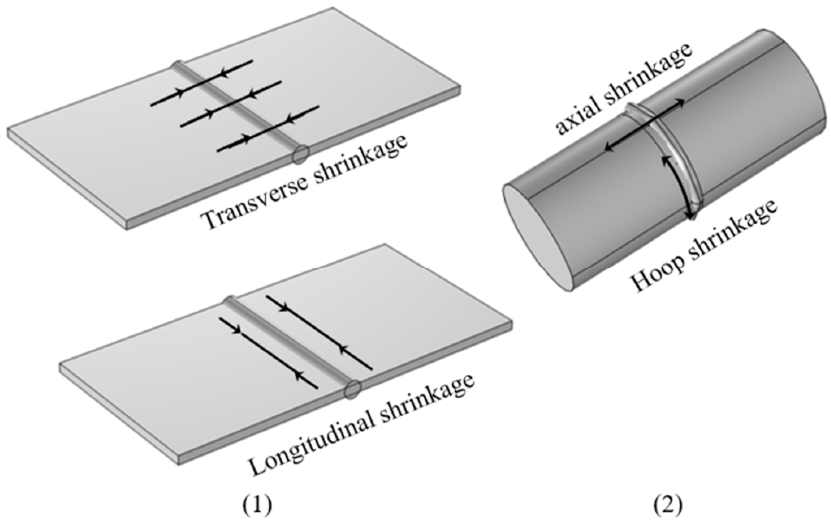
Figure 1. Elementary effects of welding for ( 1 ) welded plates ( 2 ) welded cylinders.